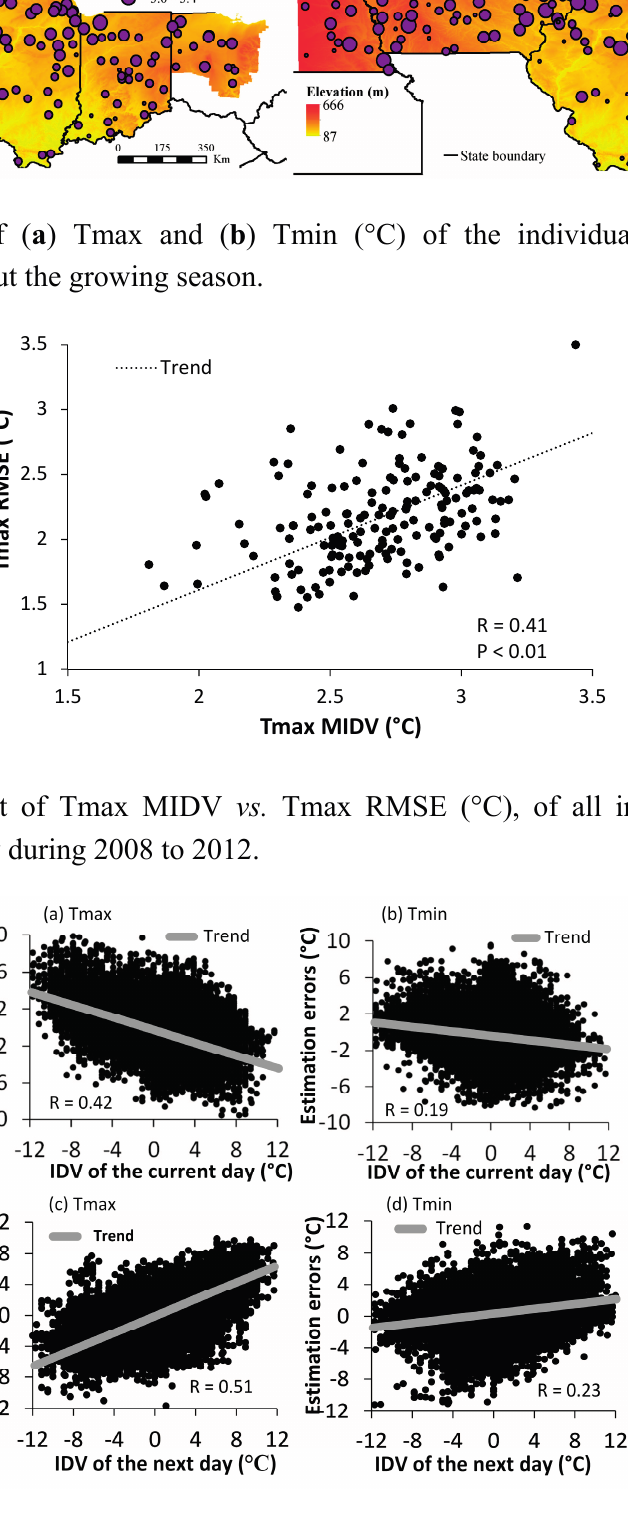
Figure 10. Scatterplot of estimation error (estimated Ta minus observed Ta) of Tmax ( a ) and Tmin ( b ) vs. the IDV of the current day (Equation (3)), and estimation error of Tmax ( c ) and Tmin ( d ) vs. the IDV of the next day (Equation (3)), for crop area during 2008–2012 throughout the growing